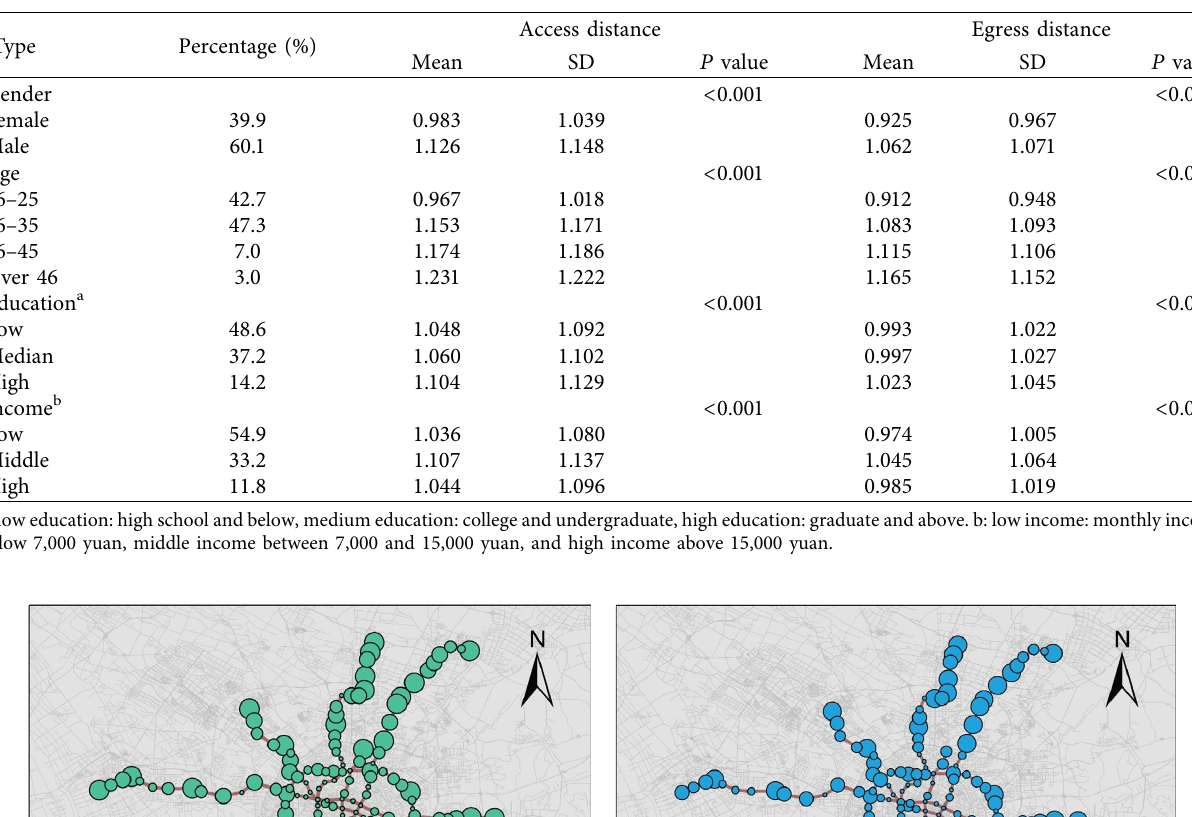
Table 5: Descriptive statistics of diferent users (unit: